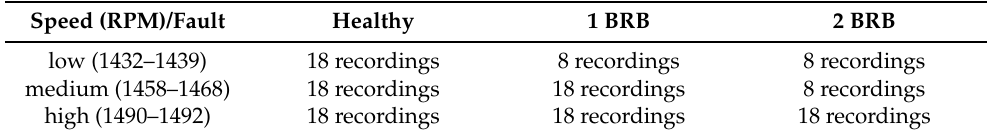
Figure 8. LIAS experimental bench, green IM to the right is the induction motor and the grey one is the DC motor, green motor in the middle is not used. Table 2. Description of broken bars dataset.